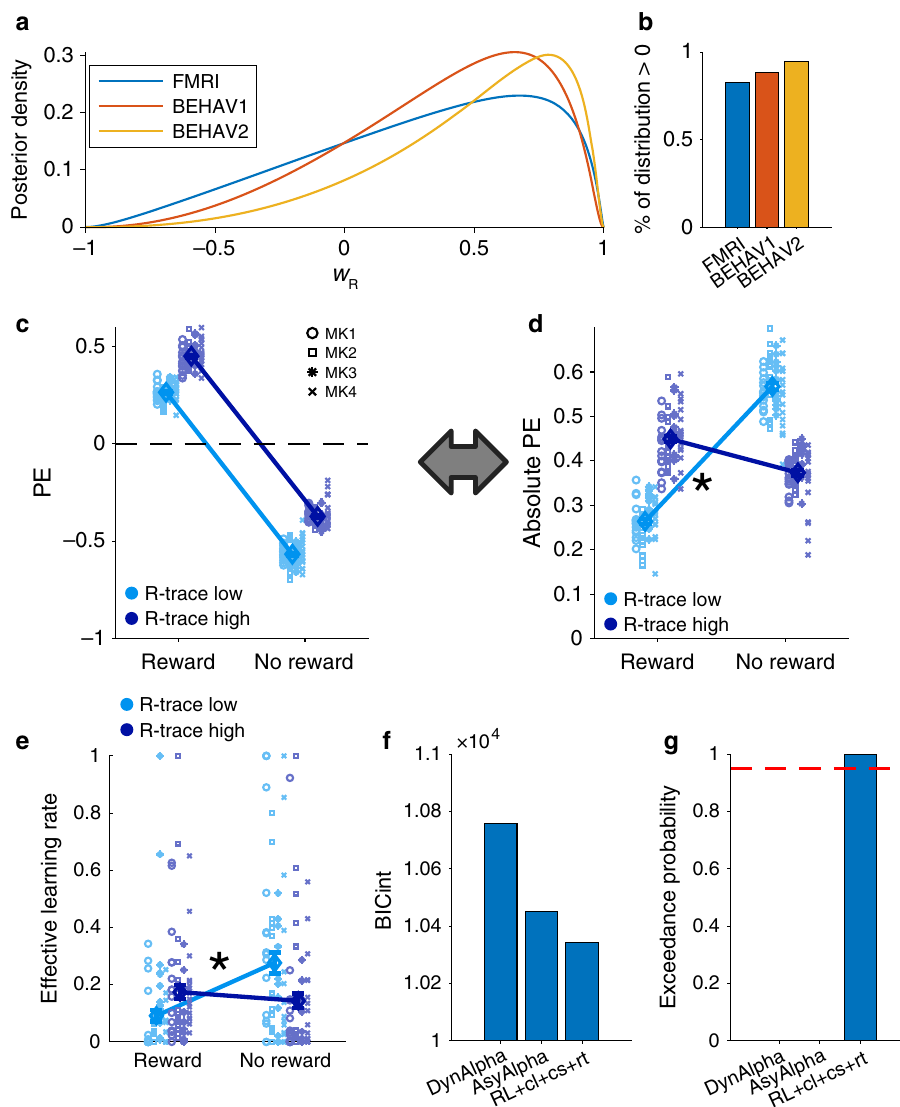
Fig. 3 GRS asymmetrically and dynamically modulates the speed of learning. a Posterior density over w R for the FMRI experiment as well as the two behavioral experiments. b Percentage of posterior distribution shown in panel a that is bigger than zero (83% for the fMRI experiment, and 87% and 95% for behavioral experiments 1 and 2, respectively). c Average PEs binned by current outcome (Reward/No reward) and R-trace (low/high; median split) show the offset of PE coding generated by positive w R . d Absolute PEs plotted as in panel c illustrate stronger positive value updates when R-trace is high and stronger negative value updates when R-trace is low (ANOVA interaction effect; asterisk indicates p < 0.001). e Estimated effective learning rates of the model demonstrate that the speed of learning differs based on both the type of current outcome and the GRS (ANOVA interaction effect; asterisk indicates p < 0.001). Note the similarity to panel d . f , g BICint and exceedance probability indicate that the full model fi ts better than one using either asymmetric (AsyAlpha) or dynamic learning rates (DynAlpha). The dashed red line indicates an exceedance probability of 0.95. (in all panels except, error bars indicate ±SEM around the mean across all experimental sessions with n = 65). Source data are provided as Source Data fi le. Symbols in panel c indicate monkey identity in panels c – e ; MK abbreviates